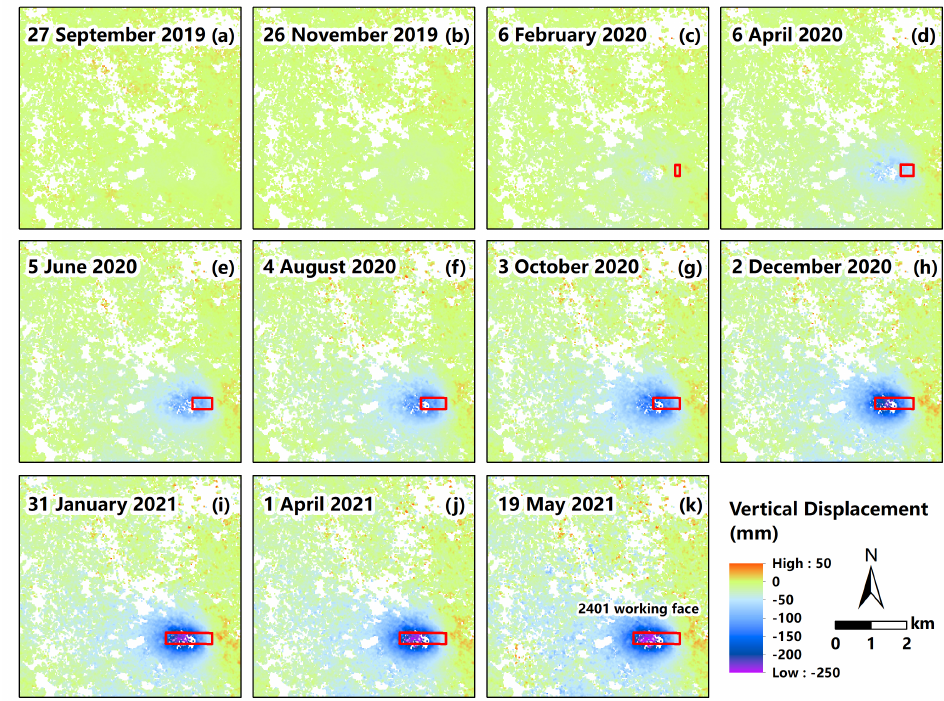
Figure 11. The dynamic evolution process of surface subsidence basin in the study area. Subfigures ( a – k ) show the distribution of cumulative surface subsidence in the study area at different dates. The layout of the 2401 working face is marked by the red